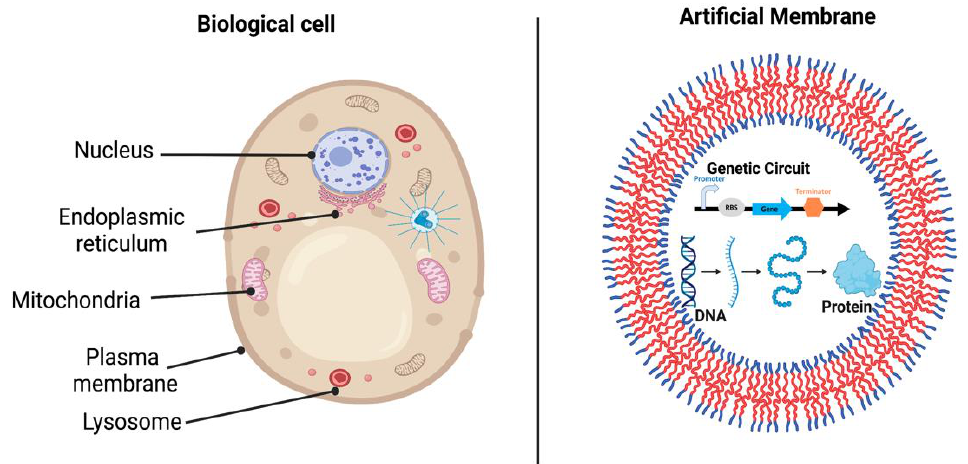
Figure 6. Architecture of typical biological cell and artificial cell. Left: Eukaryotic cell containing different types of organelles. Right: artificial “synthase” cell that mimic that structure of biological cell (Created with Biorender.com, accessed on 12 October 2022).